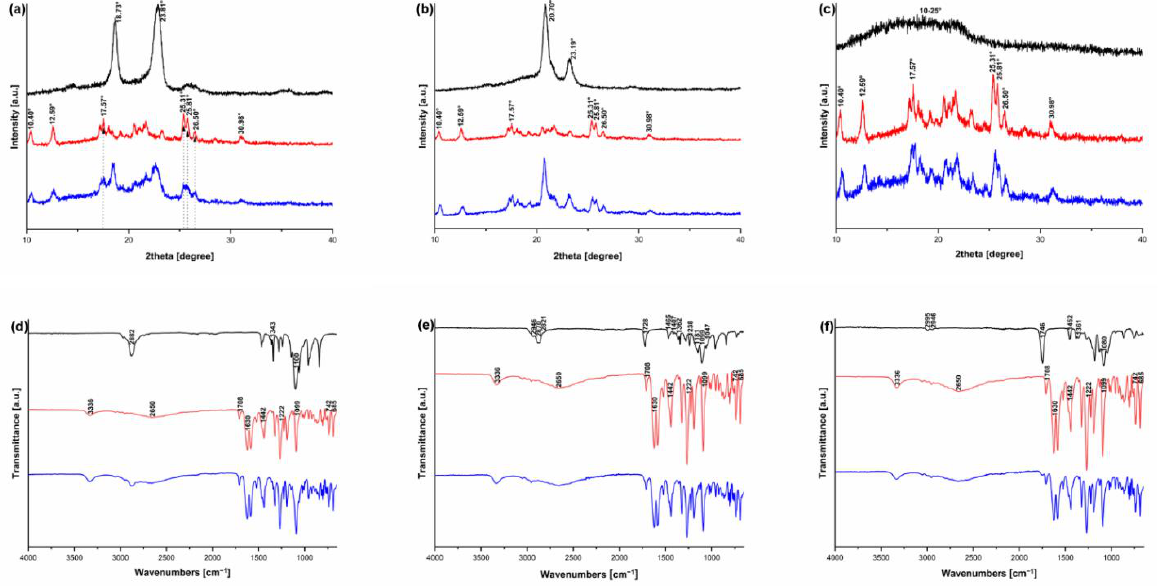
Figure 7. XRD shows the main diffraction peaks characteristic of neat Fen followed by physical mix- tures between Fen and ( a ) P 407, ( b ) PCL, and ( c ) PLA. FTIR shows the main signals characteristic of neat Fen followed by physical mixtures between fen and ( d ) P 407, ( e ) PCL, and ( f ) PLA. Fen (red), neat polymers (black), and physical mixtures (blue).